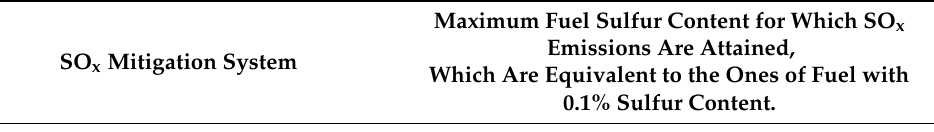
Table 12. Consolidation of data for SO x capture rate per type of exhaust gas treatment system. (Table was genuinely generated using data from ref.